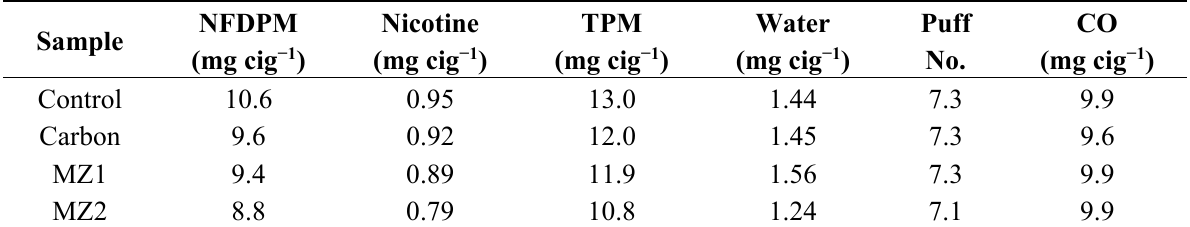
Table 3. Smoking data of cigarette X148 and the one with additives in the filter.